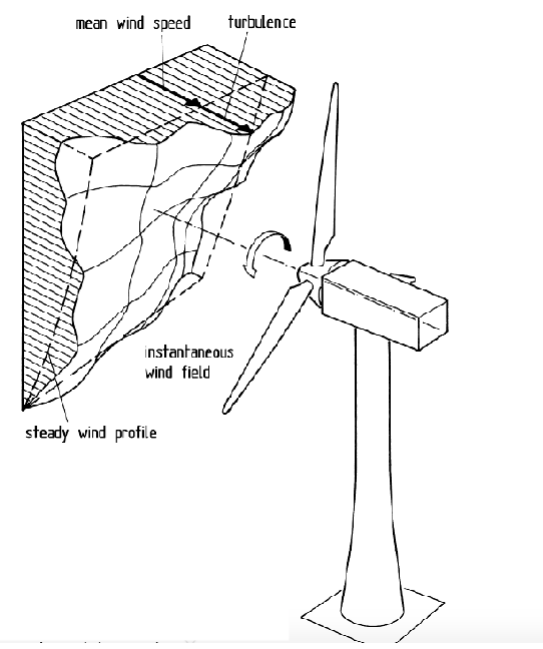
Figure 6. Effect of an uneven wind-speed distribution over the swept rotor area on the upwind velocity of the rotating rotor blade